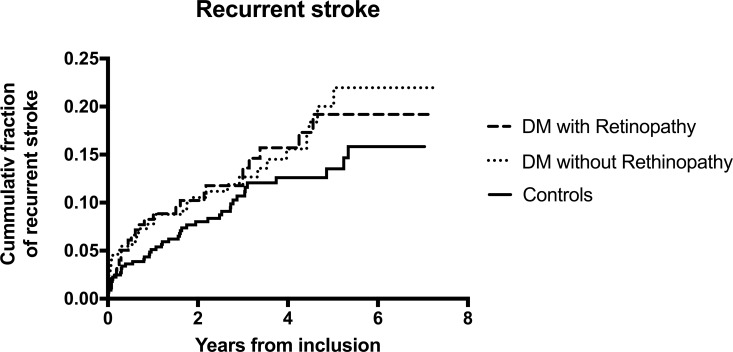
Kaplan-Meier curve of the cumulative proportion with recurrent stroke.P-value for the difference between patients with and without diabetes was 0.07. P-value for the difference between diabetes patients with and without retinopathy was 0.96.